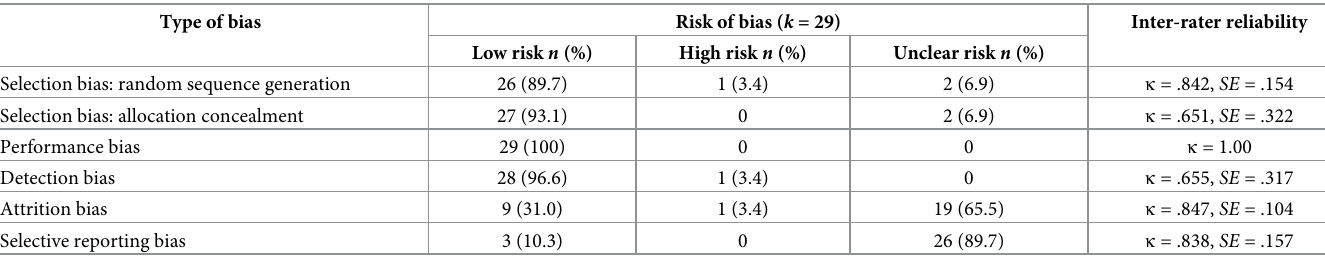
Table 2. Frequency table of within study risk of bias in